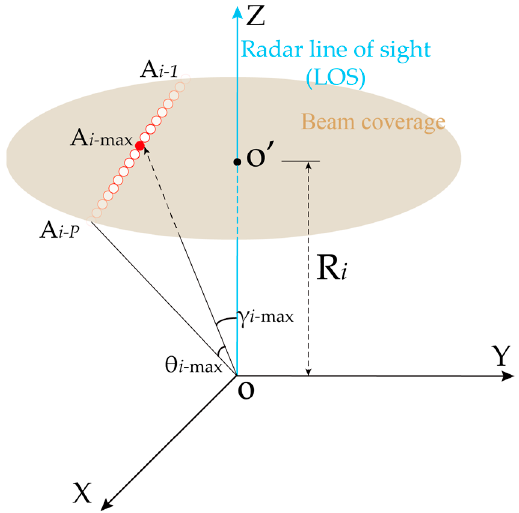
Figure 4. Insect crossing beam model diagram.